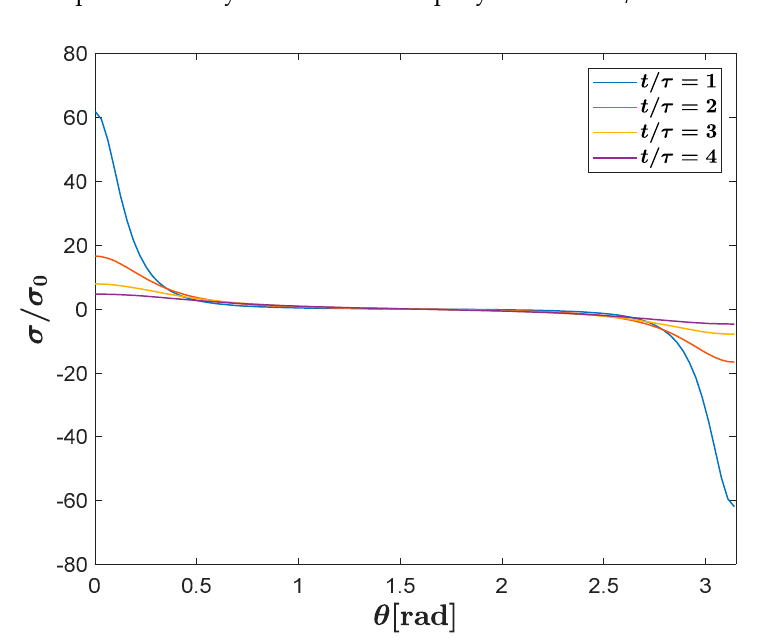
Figure 2. Surface charge distribution on the void surface as a function of time for 0 ≤ θ ≤ π . σ 0 = q / 4 π a 2 and τ = ε 0 a / k s . It is assumed q = 80 pC, k s = 1 × 10 − 12 S · m − 1 and a = 0.55 mm.